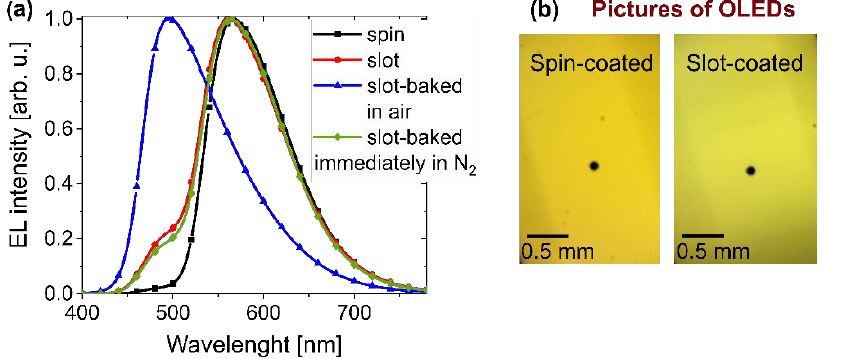
Figure 6. ( a ) Normalized EL spectra and ( b ) pictures of working devices based on emissive layer (PVK + 25 wt.% SpiroAC-TRZ + 2 wt.% Ir) prepared by means of spin- or slot-die coating techniques. Dark dots visible on the pictures are related to the marked measurement areas.